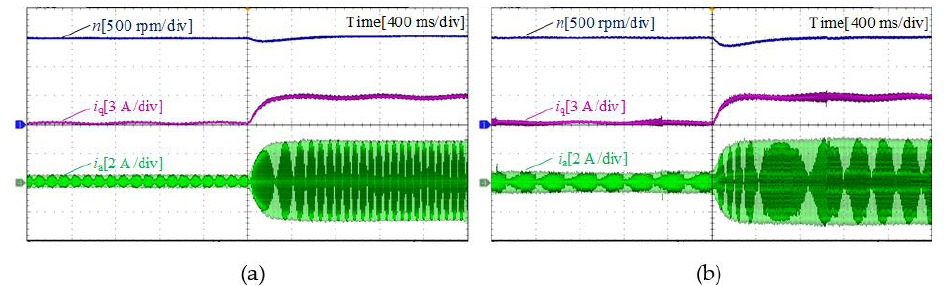
Figure 7. Dynamic experimental waveforms when the load torque suddenly changes from 0 Nm to